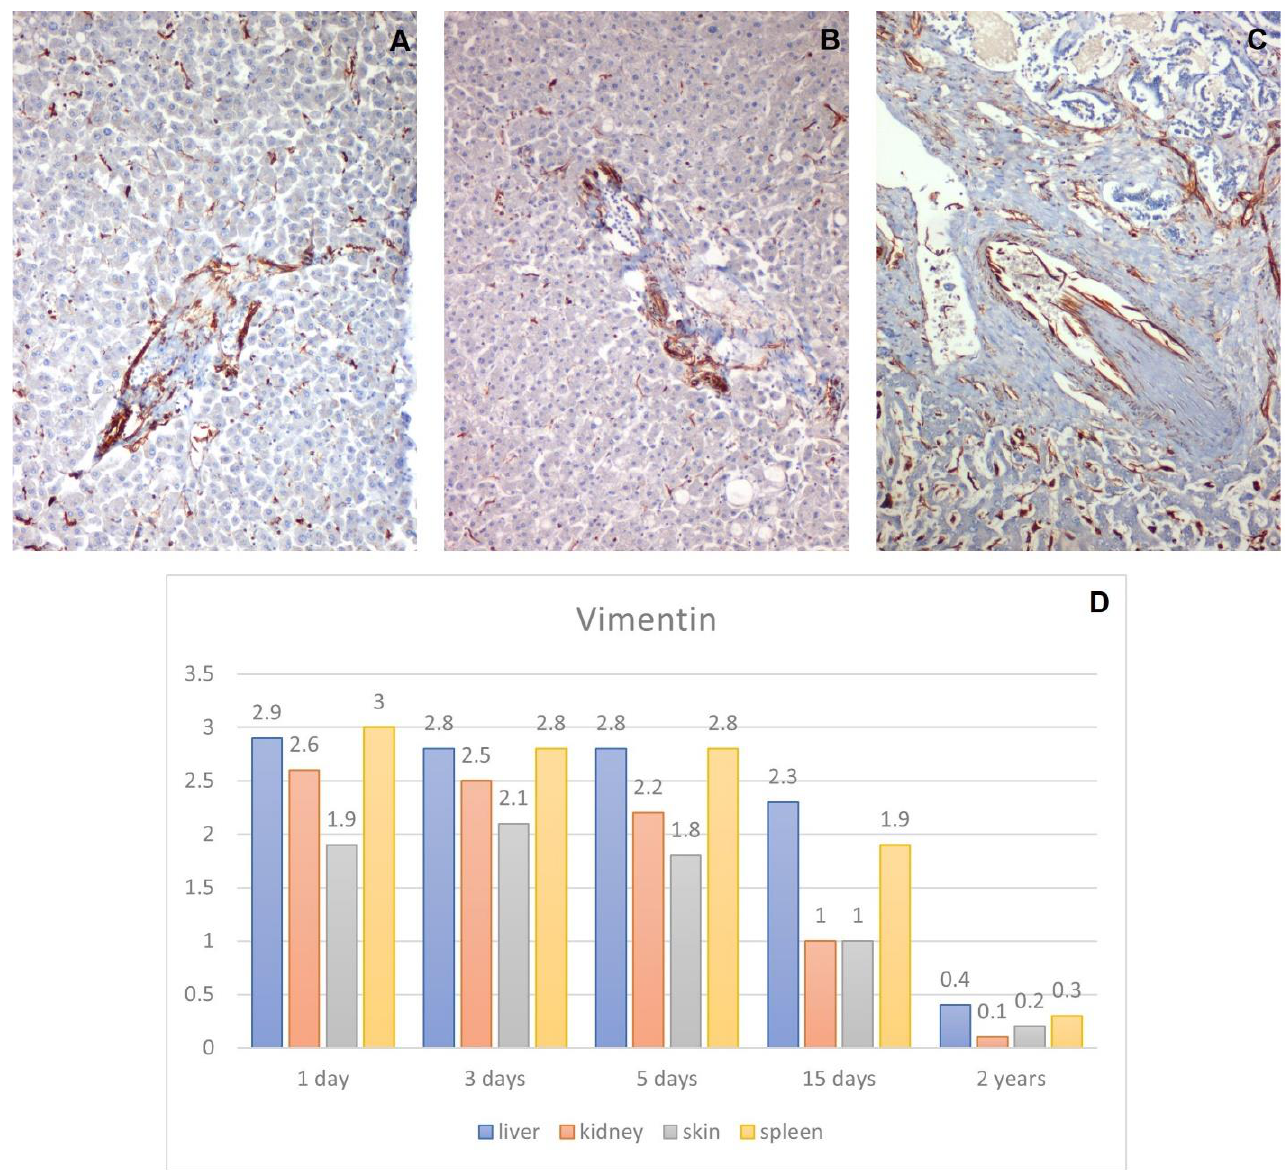
Figure 5. Immunohistochemical analysis of vimentin . ( A ) high vimentin expression in liver taken 1 day after death, 10×. ( B ) High vimentin expression in liver taken 3 days after death, 10×; ( C ) high vimentin expression in liver taken 15 days after death, 10×. ( D ) Graph shows the intensity of vimentin immunostaining (score 0 – 3).